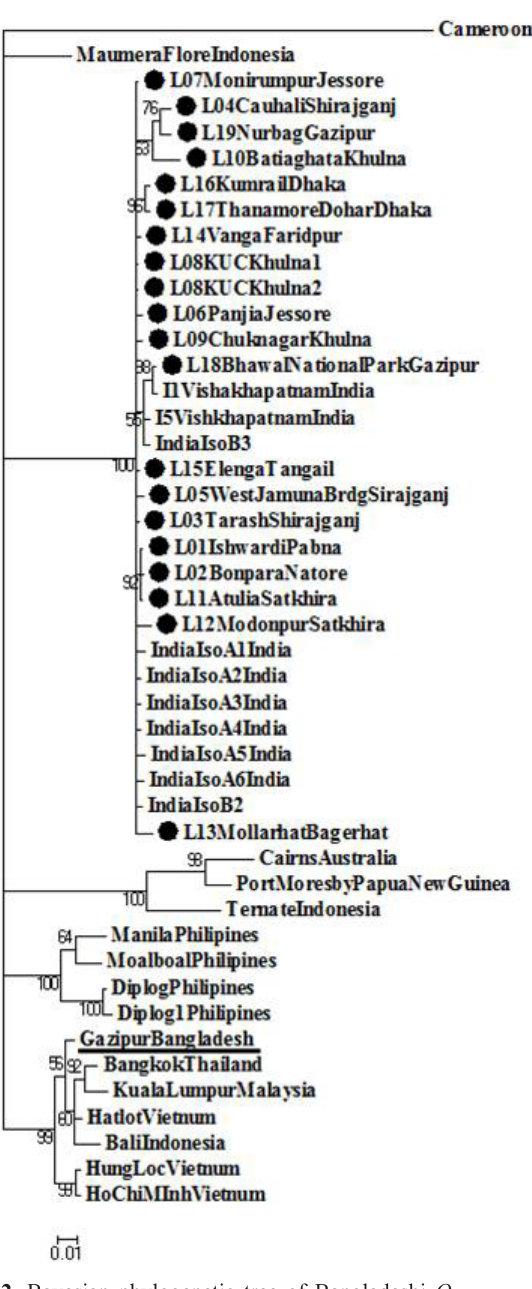
Fig 2 . Bayesian phylogenetic tree of Bangladeshi O. smaragdina populations as inferred from the mitochondrial gene fragments of the COI and the Cytb genes. Numbers adjacent to internal nodes represent bootstrap values (%). Black circles indicate the samples from Bangladesh in the present study. Additional DNA sequence data were downloaded from DDBJ GenBank. The underlined locality shows the Bangladeshi sample in the previous study of Azuma et al. (2006). The number ahead of each locality indicates the locality